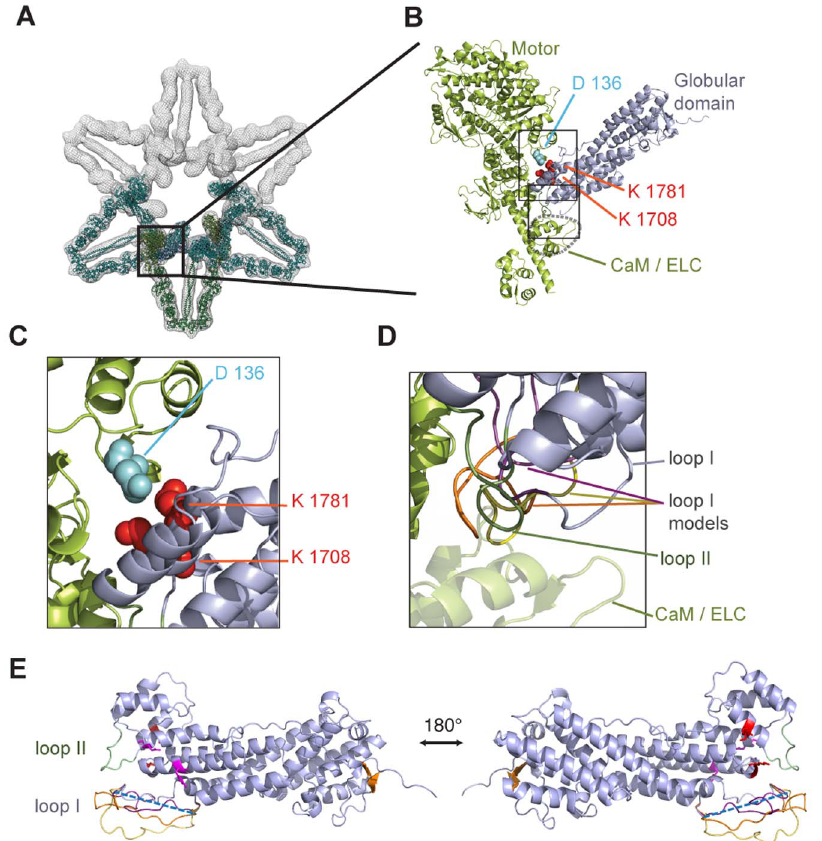
Figure 4. Autoinhibition of type V myosins by their globular domains involves multiple interactions sites. ( A ) Docking of our high resolution Myo5a GD structure into a previously published 24 A˚ electron density map of the inhibited Myo5a motor [21] (PDB-ID of published model lacking the globular domain: 2DFS). Shown are three modeled myosin dimers in the EM density (meshed surface rendering) that are arranged in a flower-like fashion. The color scheme is as follows: blue, Myo5a GD; green, motor domain, lever arm, light chains, coiled coil domain; turquoise, neighboring dimers. ( B ) Close-up of (A), depicting the Myo5a head complex (green) and the fitted GD (blue). Residues previously reported to be required for autoinhibition [23] are shown as colored spheres. ( C ) Close-up of the upper rectangle in (B). ( D ) Close-up of the lower rectangle in (B). Loop I is disordered in the structural data. Depicted are three computed models for the flexible loop I, highlighted in yellow, orange, and magenta. ( E ) Atomic model of Myo5a. Missing amino acids of the flexible loop I GD are depicted as a blue dashed line (disordered loop I: 1640–1658), loop II in green (1787–1797), and amino acids important for interaction with the motor domain are highlighted in red (K1708, K1781). Residues important for Rab11a binding (Y1721 and Q1755) are shown in magenta and the beta-sheet is depicted in orange. Computed models for the flexible loop I were depicted in yellow, orange, and magenta (see also D). Figures were generated with the program Pymol.